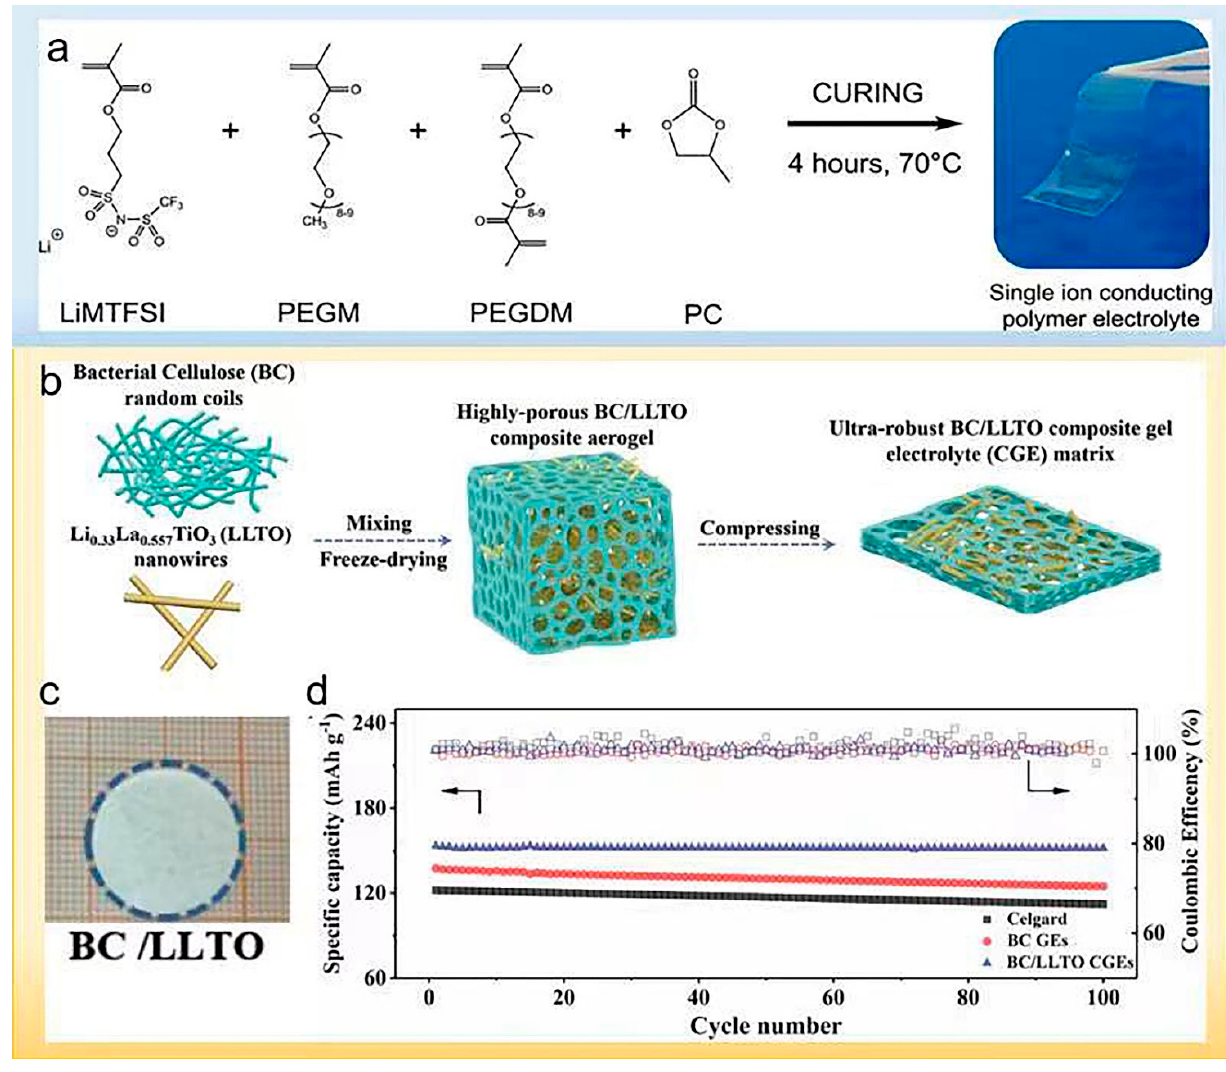
Figure 11. ( a ) General pathway for the preparation of SIPE films. Reproduced with permission [97]. Copyright 2016, American Chemical Society. ( b ) Schematic illustration of the fabrication of multifunctional BC/LLTO CGE matrix. ( c ) Optical photograph of thermal shrinkage BC/LLTO CGE matrix after exposure to 150 °C for 2 h. ( d ) Cycle performance of BC/LLTO CGEs at 0.2 C as compared with the counterparts [100]. Reproduced with permission. Copyright 2020, John Wiley and Sons.